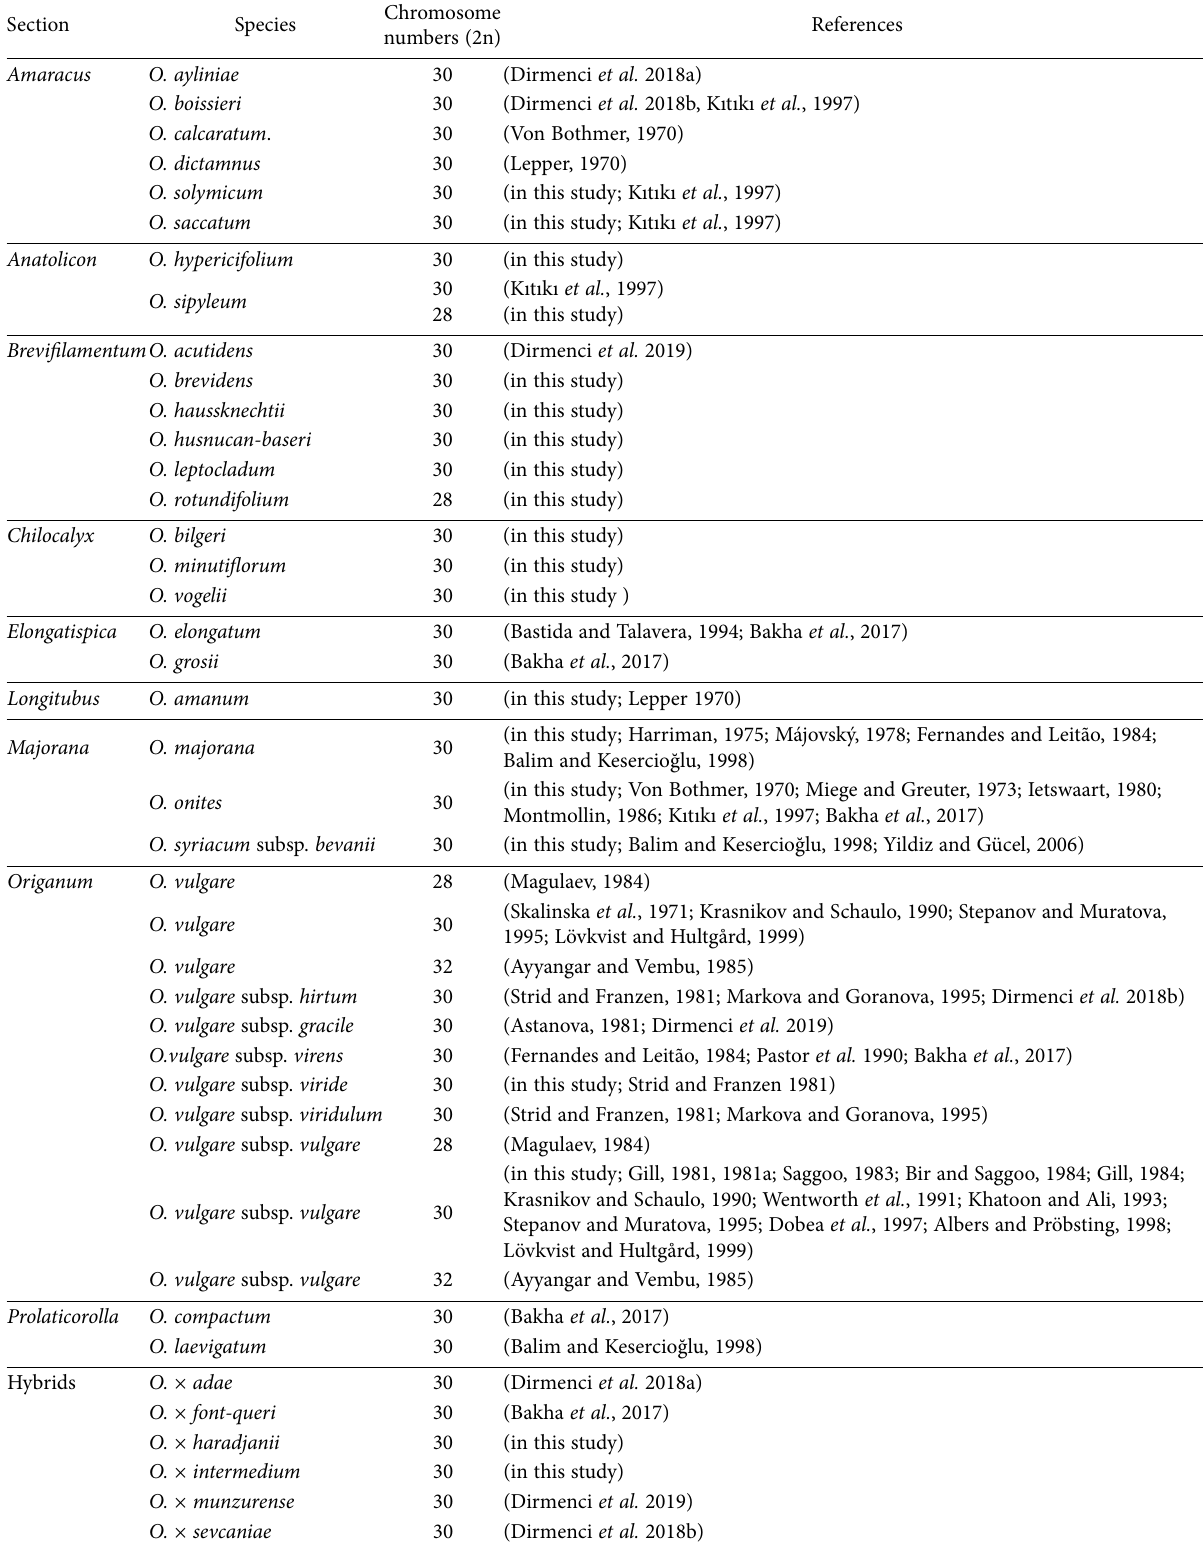
Table 2. Chromosome counts of species and hybrids of Origanum according to